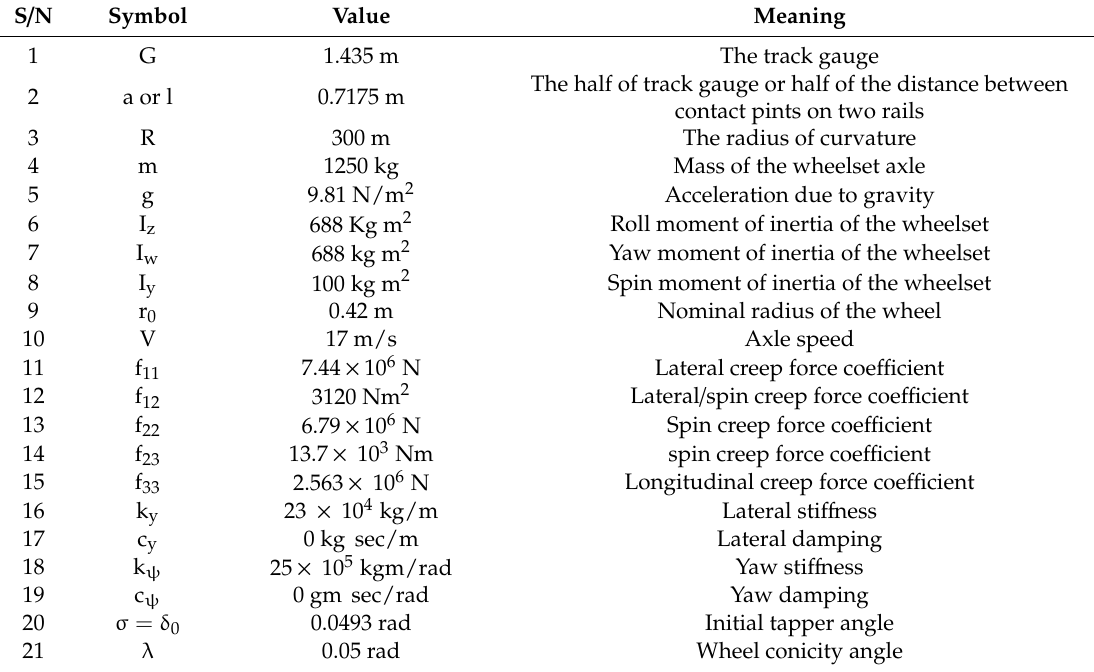
Table 1. The constants used in the wheelset dynamic